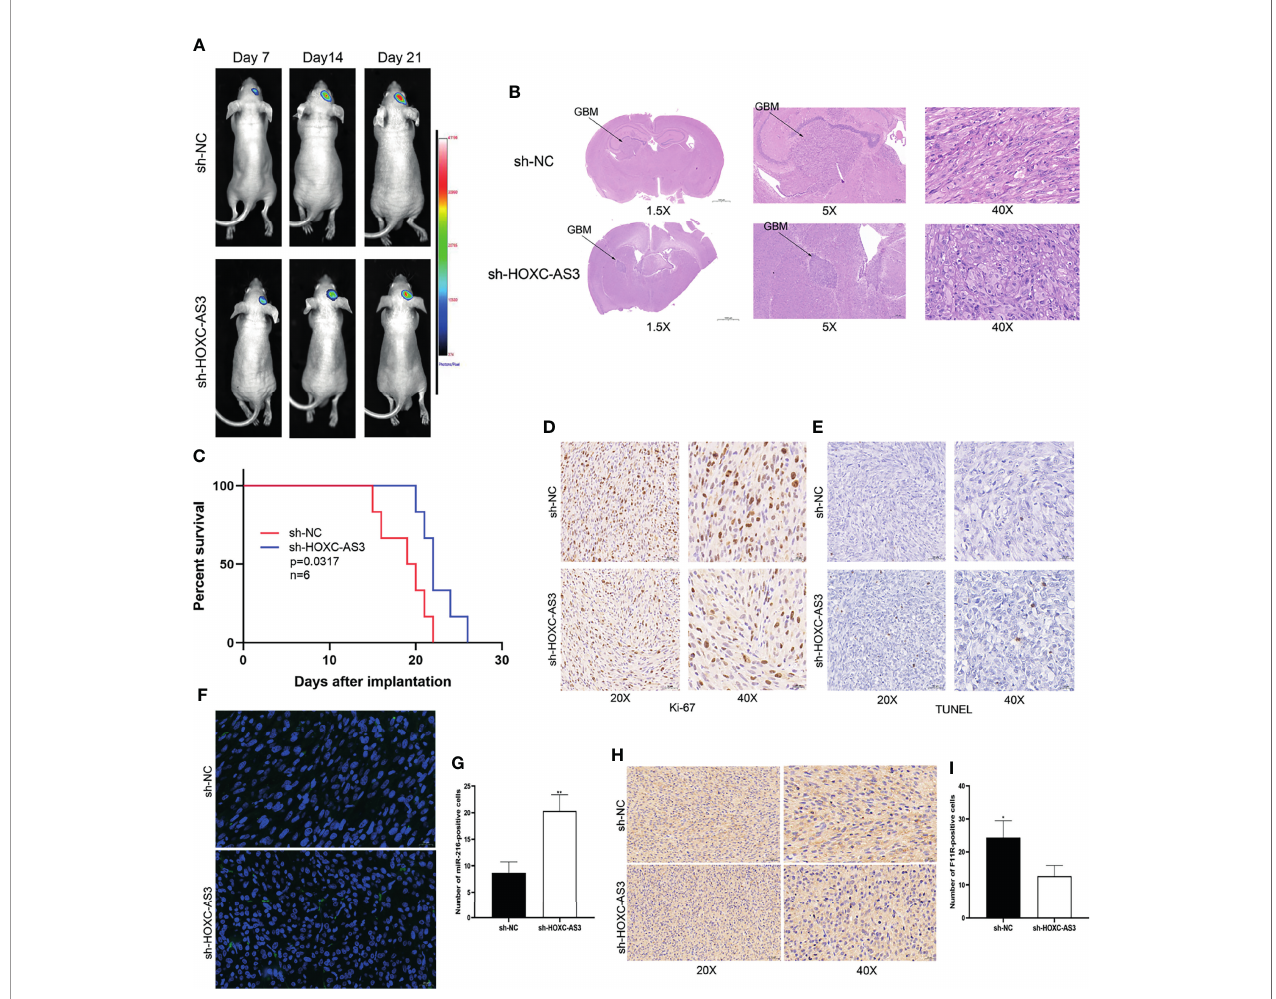
FIGURE 6 | HOXC-AS3 promotes glioma growth in vivo . (A) Luciferase signals were assessed at 7,14 and 21 days after implantation of glioma cells (6 mice per group). (B) Tumor maximum diameter was determined using H&E staining. (C) Overall survival of the sh-HOXC-AS3 and control groups was compared by Kaplan- Meier survival curves. (D) Ki-67 expression in the sh-HOXC-AS3 and sh-NC groups was measured by immunohistochemistry. (E) TUNEL staining was used to detect cell apoptosis in the sh-HOXC-AS3 and sh-NC groups. (F, G) Expression and quanti fi cation of miR-216 in the brain sections. (H, I) Expression and quanti fi cation of F11R in the brain sections. Log-rank test for (C) and t-test for (G, I) . *P < 0.05, **P <